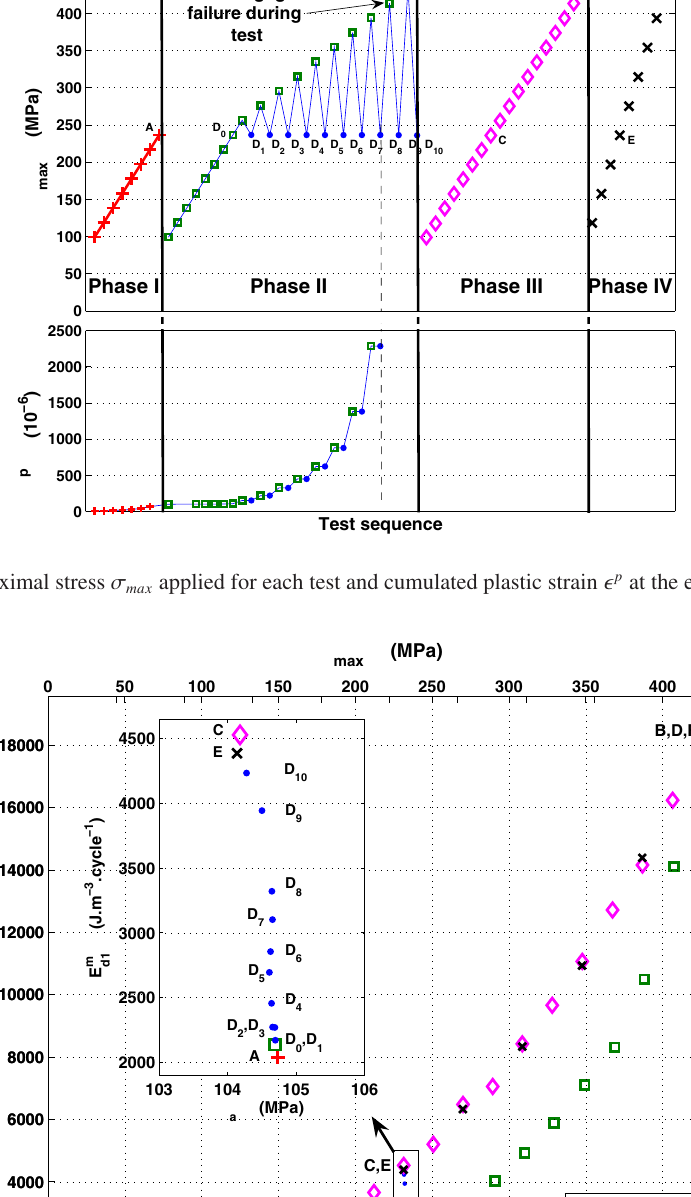
versus alternate stress σ a (bottom scale) and maximal stress σ max d 1